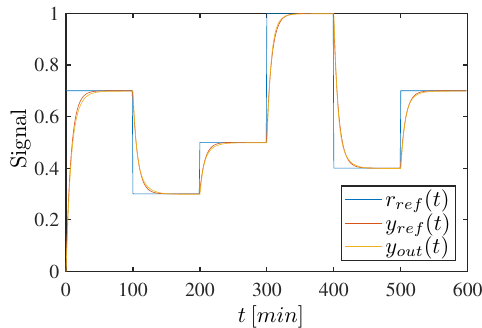
Figure 29. Controller results with different